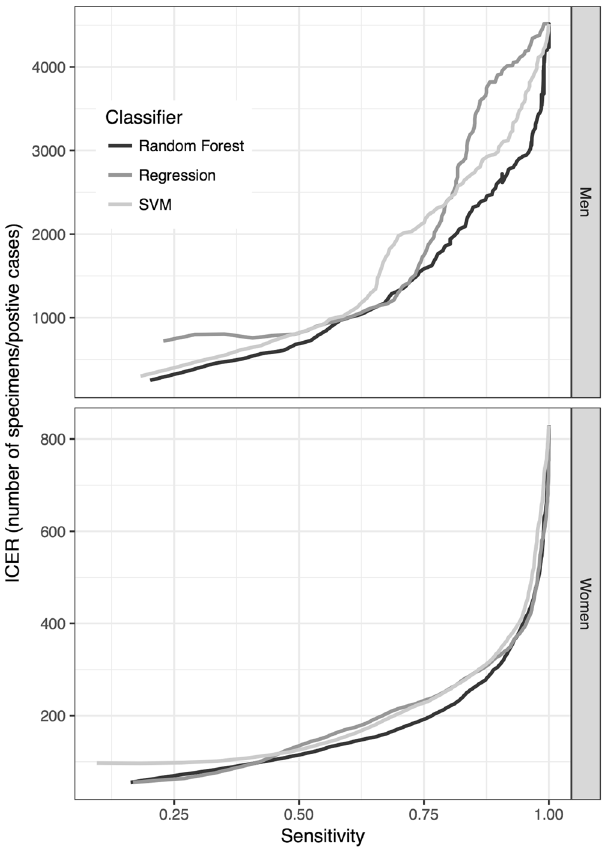
Figure 5. Curves showing ICERs at different sensitivity levels. The ICER is defined as the number of specimens microscopically examined divided by the number of positive cases found. ICER: incremental cost-effectiveness